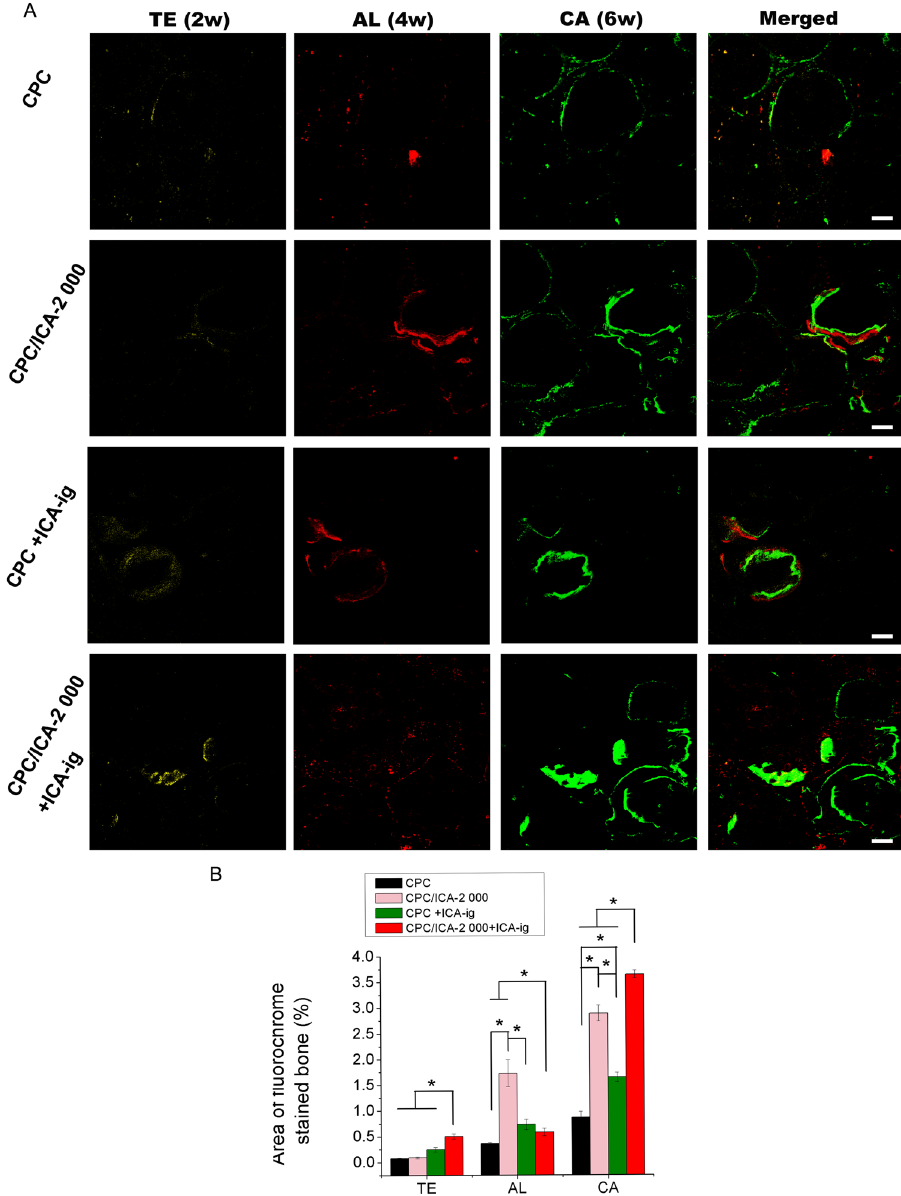
Figure 5. Sequential fluorescent labeling of TE, AL and CA for CPC, CPC/ICA-2 000, CPC + ICA-ig, and CPC/ICA-2 000 + ICA-ig groups. The images in yellow (TE), red (AL) and green (CA) indicated the rate of bone formation and mineralization at 2, 4 and 6 weeks after the operation, respectively. Merged images of the three fluorochromes for the same group. Scale bar = 100 μ m. ( B ) The percentage of TE, AL and CA staining by histomorphometric analysis ( * p <